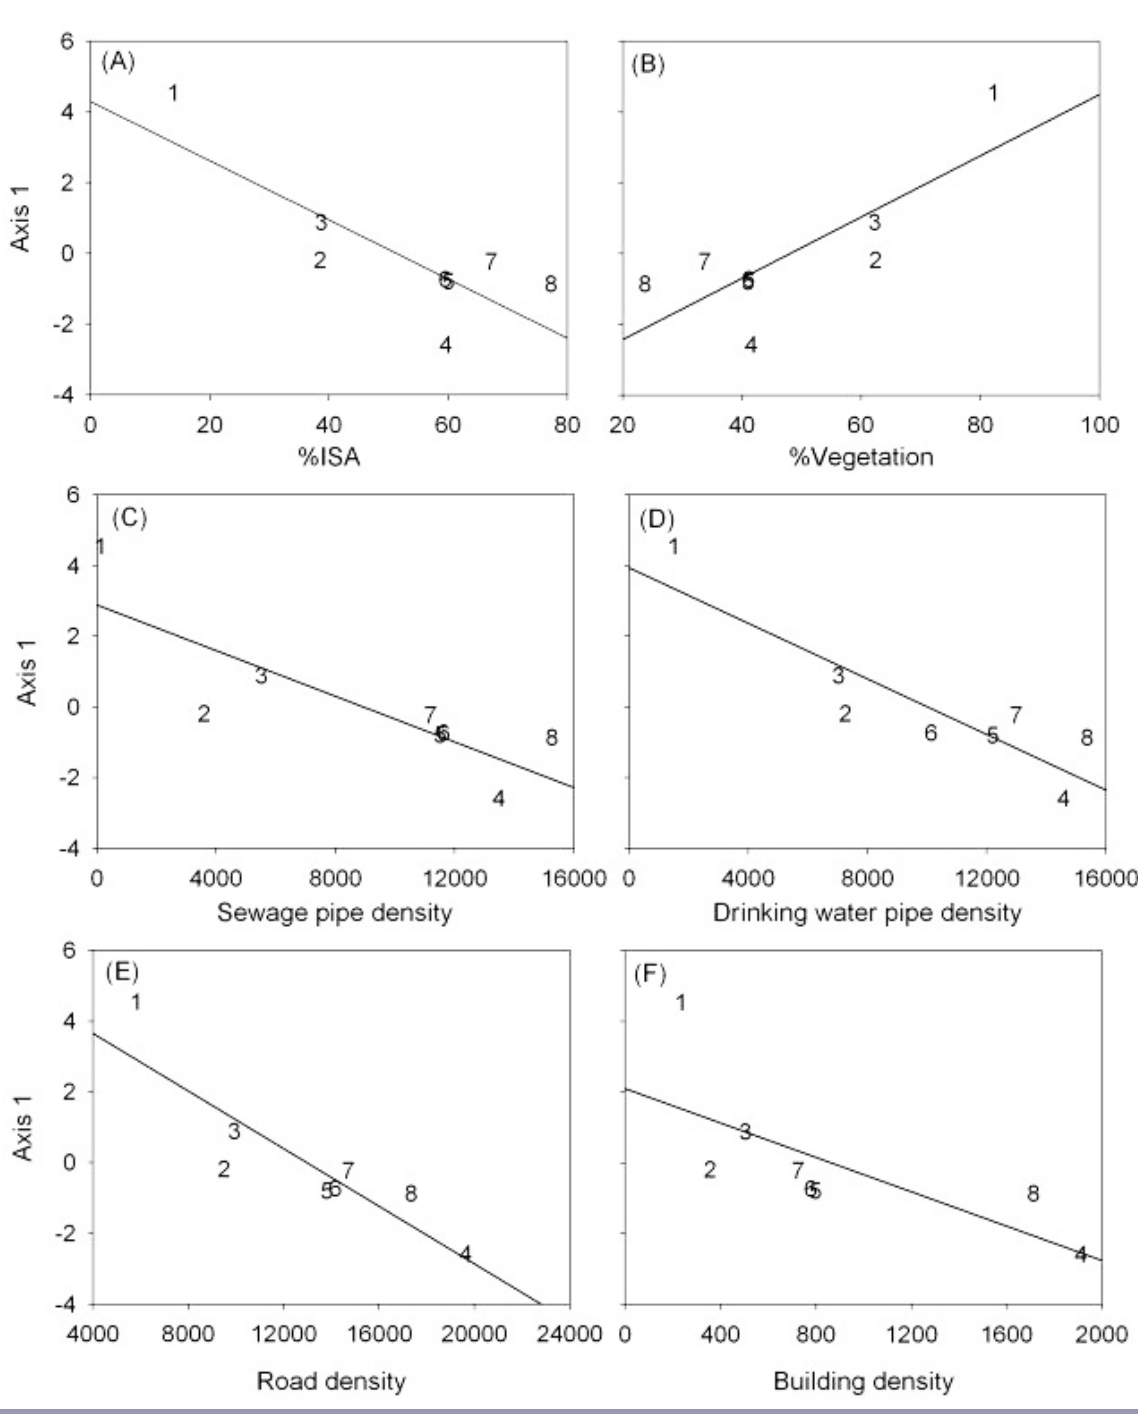
Fig. 6 . Regression analysis between watershed infrastructure density and Principal Component Analysis (PCA) axis 1. (A) percent impervious surface area (ISA) versus Axis 1 (r2 = 0.66, p = 0.01), (B) percent vegetation versus Axis 1 (r2 = 0.62, p = 0.02), (C) sewage pipe density versus Axis 1 (r2 = 0.68, p = 0.01), (D) drinking pipe density versus Axis 1 (r2 = 0.78, p < 0.01), (E) road density versus Axis 1 (r2 = 0.78, p < 0.01), (F) building density versus Axis 1 (r2 = 0.51, p =